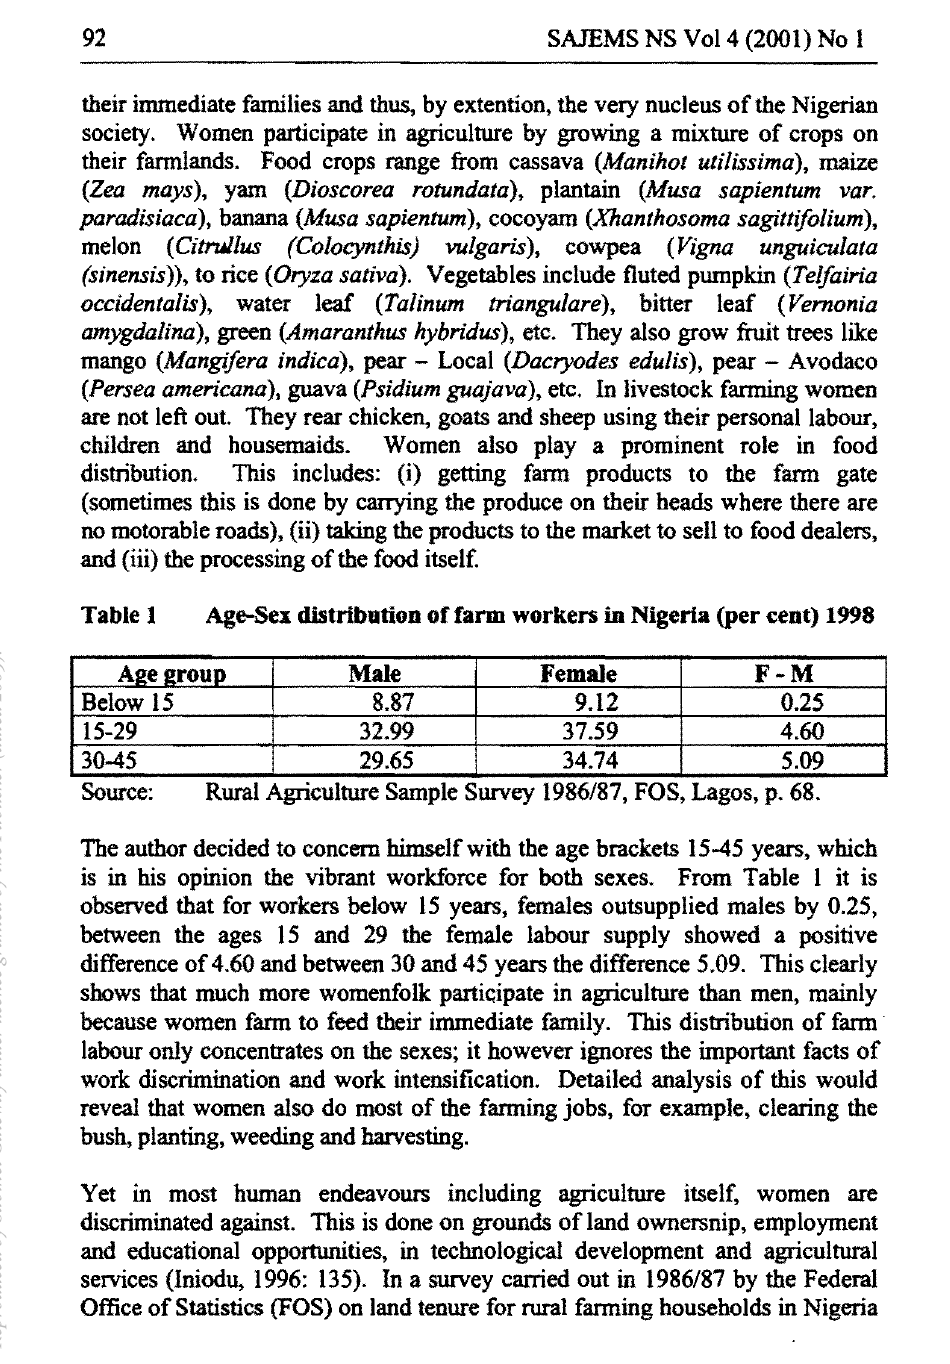
Age-Sex distribution o( (ann workers in Nigeria (per cent) 1998 Age group Male Female F-M Below 15 8.87 9.12 0.25 15-29 32.99 37.59 4.60 30-45 29.65 34.74